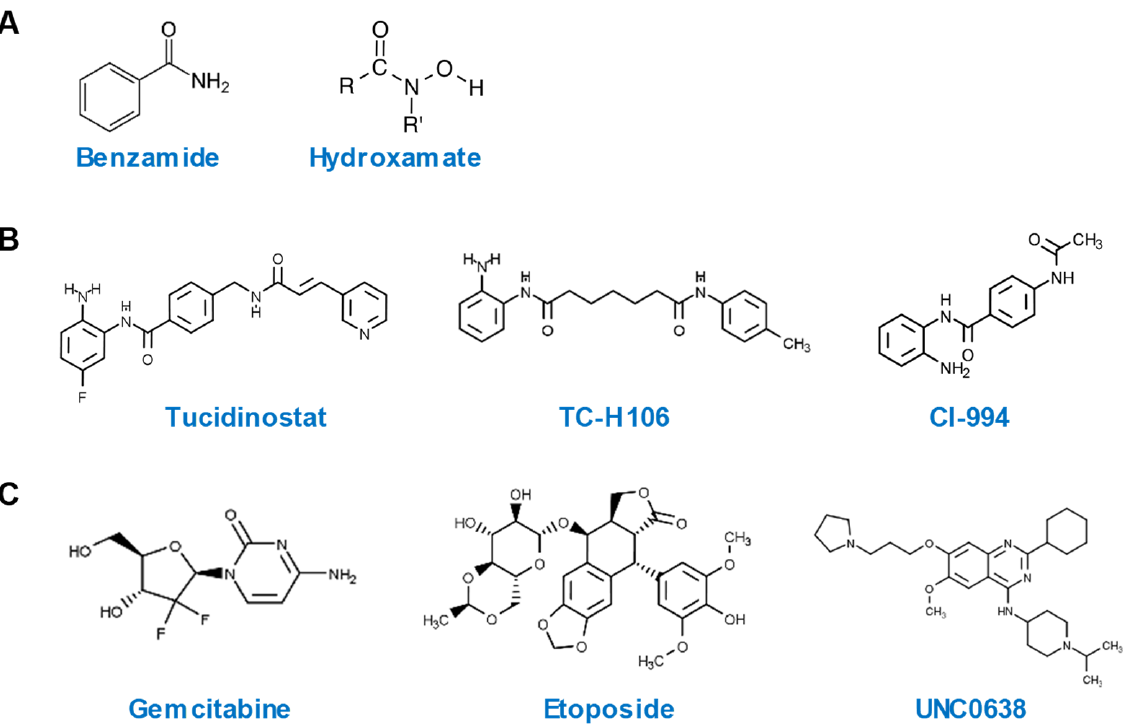
Figure 4. Chemical structures of highly potent HDP-inducing epigenetic compounds. ( A ) Chemical structures of benzamide and hydroxamate. ( B ) Chemical structures of three potent HDP-inducing HDACi. ( C ) Chemical structures of three potent HDP-inducing non-HDACi.